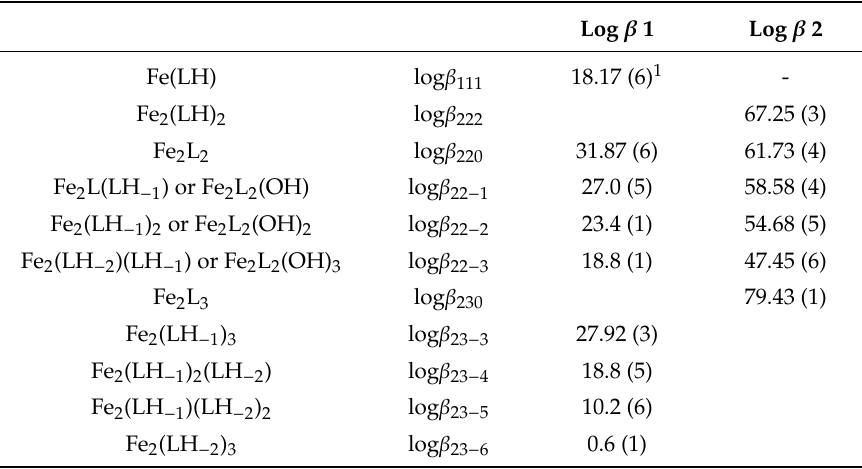
Table 2. Global formation constant of Fe(III)- 1 and Fe(III)- 2 complexes.